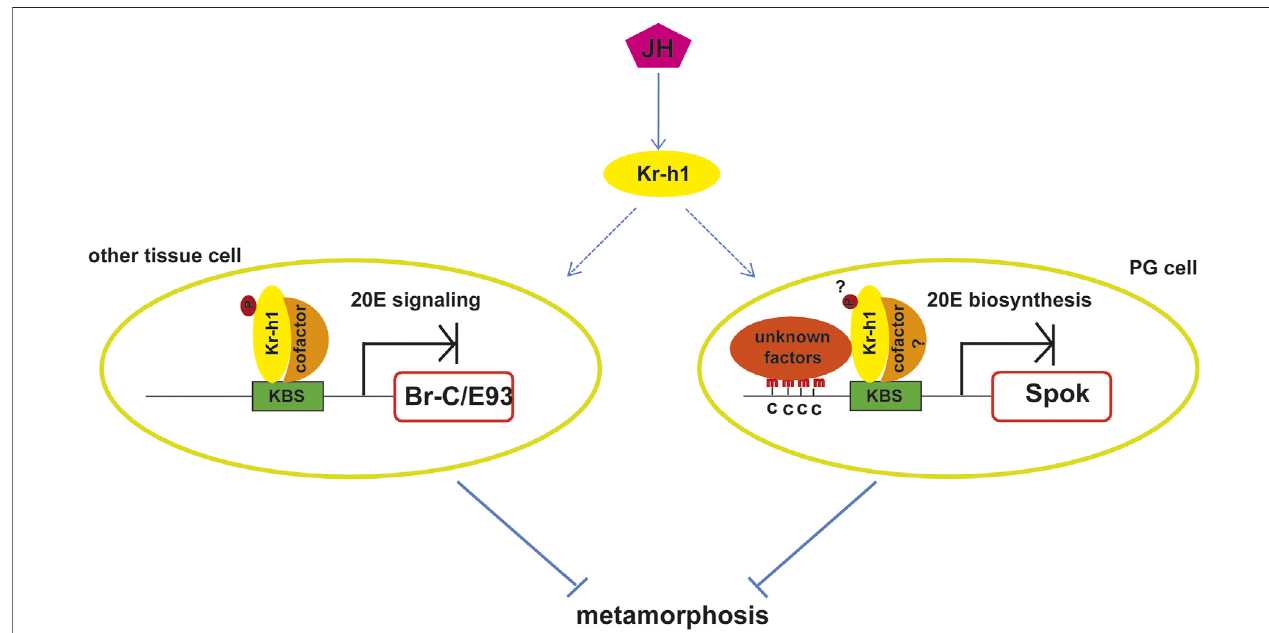
FIGURE 2 | Molecular mechanisms of the anti-metamorphic action of Kr-h1. JH prevents insect metamorphosis by activating Kr-h1 expression. Kr-h1 binds directly to the KBS in the promoters of pupal speci fi er gene Br-C or adult speci fi er gene E93 to inhibit their expression, which in turn prevent pupal metamorphosis or adult metamorphosis. This action requires the phosphorylation of Kr-h1 and the recruitment of cofactors. Kr-h1 could also prevent metamorphosis via repressing the expressionofenzymesinvolvedin20Ebiosynthesis,suchas Spok .ThebindingofKr-h1totheKBSinthepromoterof Spok inducestheadjacentDNAmethylation byunknownfactors,whichleadstotherepressionof Spok expression.WhetherthisactiondependsonthephosphorylationofKr-h1andtheassociationwithcofactorsis unknown. KBS, Kr-h1 binding site; p, phosphorylation modi fi cation; c, cytosine; PG, prothoracic gland.